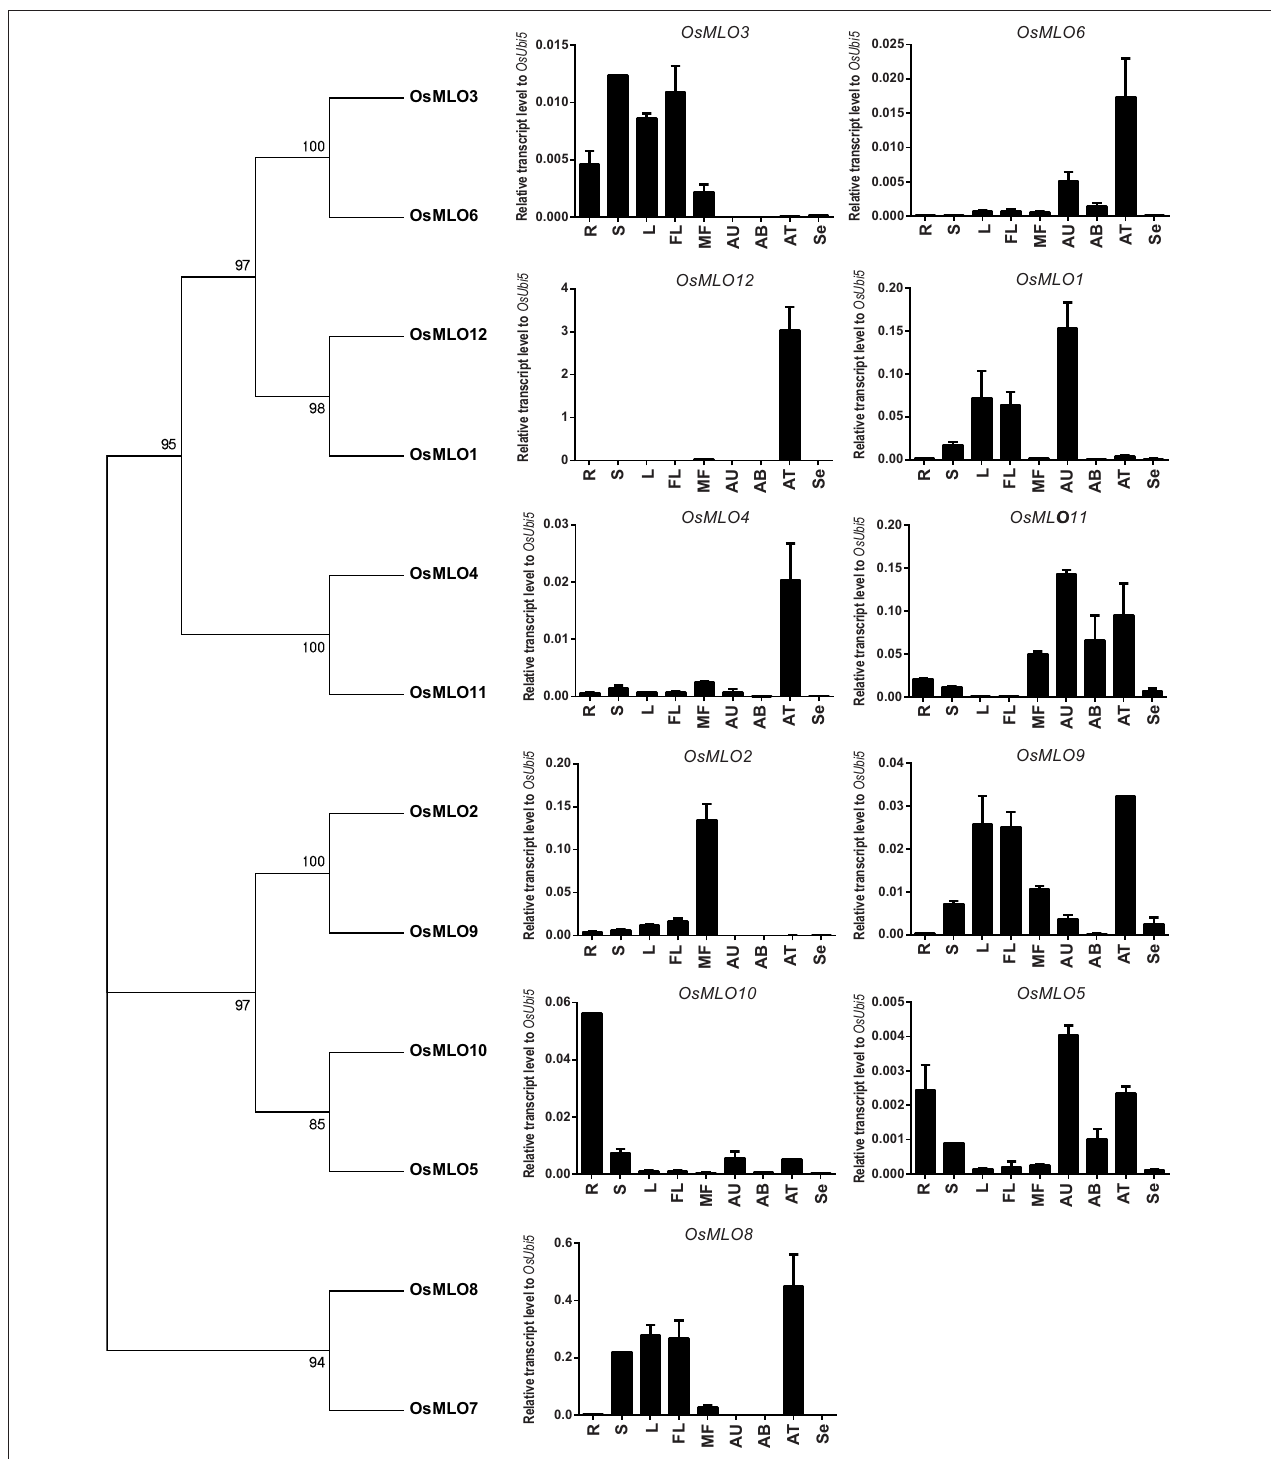
FIGURE 2 | Real-time expression profiles for 12 OsMLO genes. Anatomical samples were prepared from root (R), shoot (S), mature leaf (L), young panicle (3cm-YP), mature flower (MF), anther [uni- (AU), bi- (AB), and tricellular (AT)], and seed at 6 days after pollination (Se). Rice ubiquitin ( OsUbi5 ) was served as internal